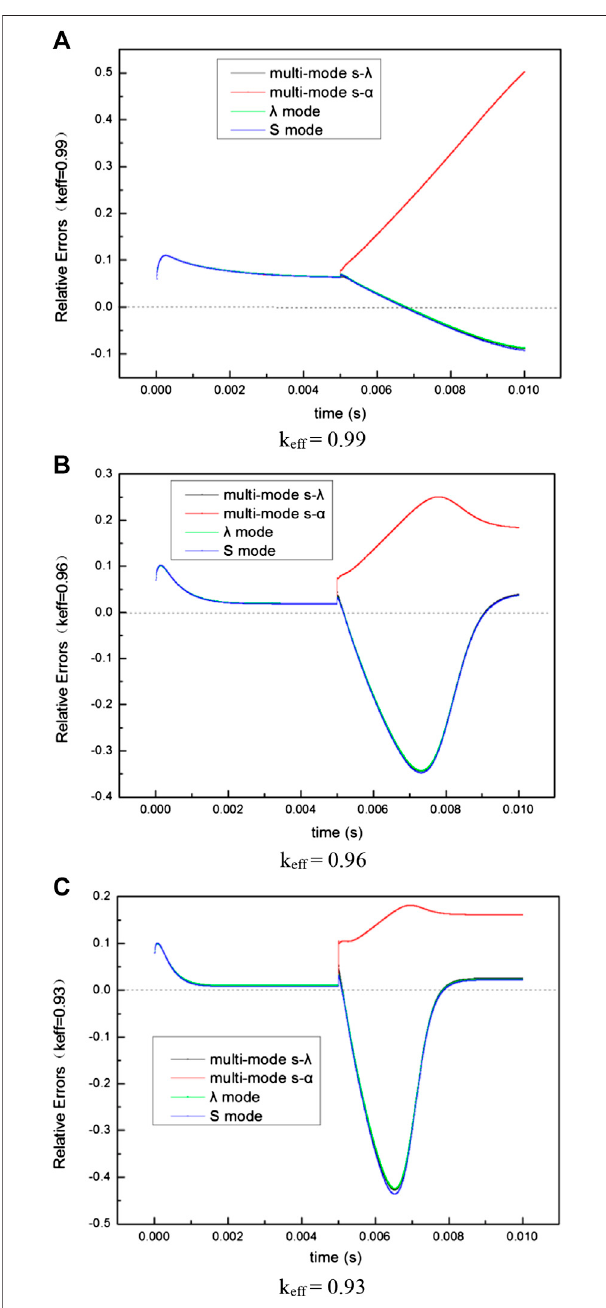
FIGURE 3 | Relative errors of the beam transients under various sub- criticalities.